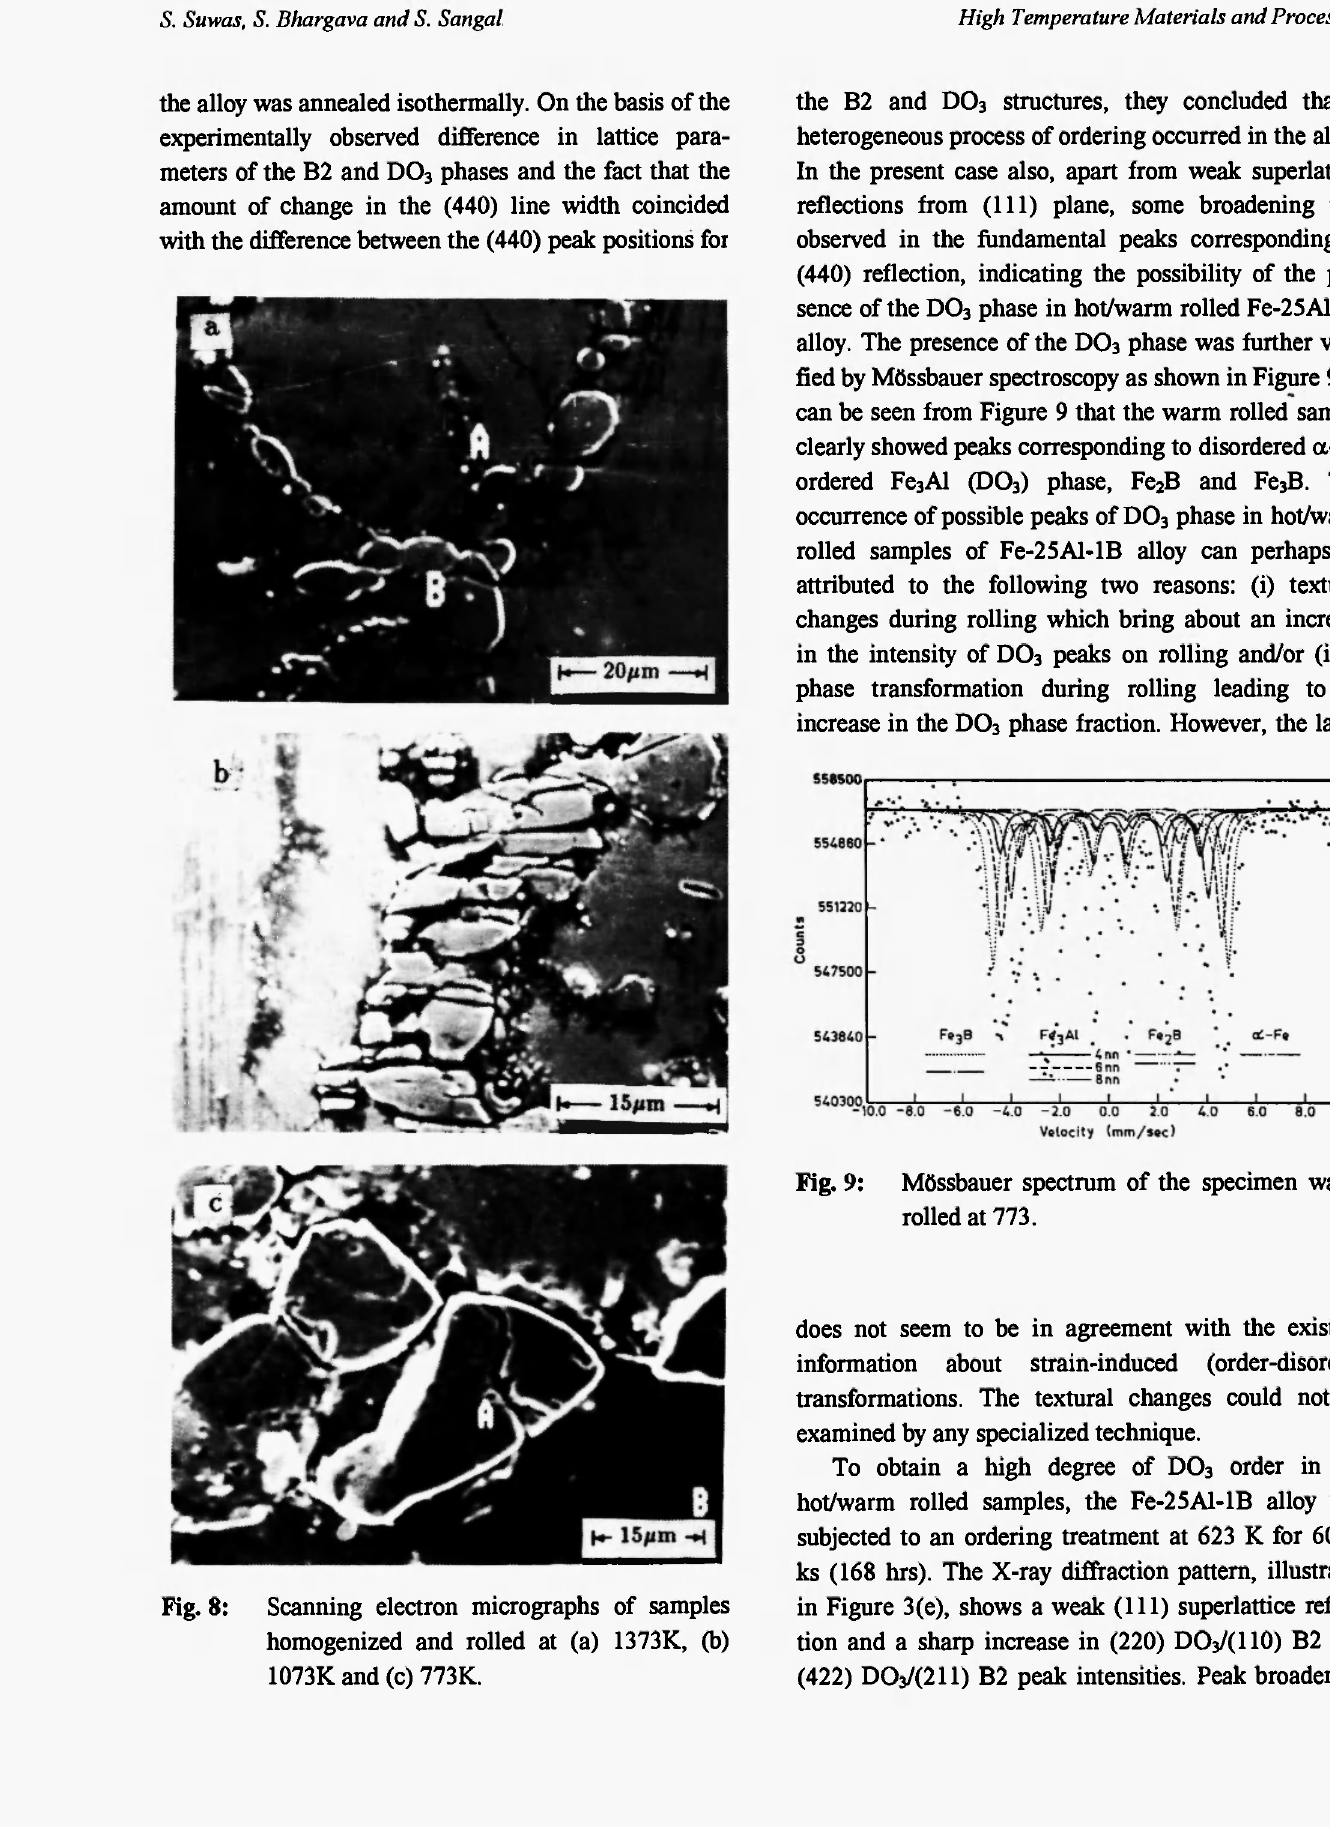
Fig. 8: Scanning electron micrographs of samples homogenized and rolled at (a) 1373K, (b) 1073K and (c) 773K.